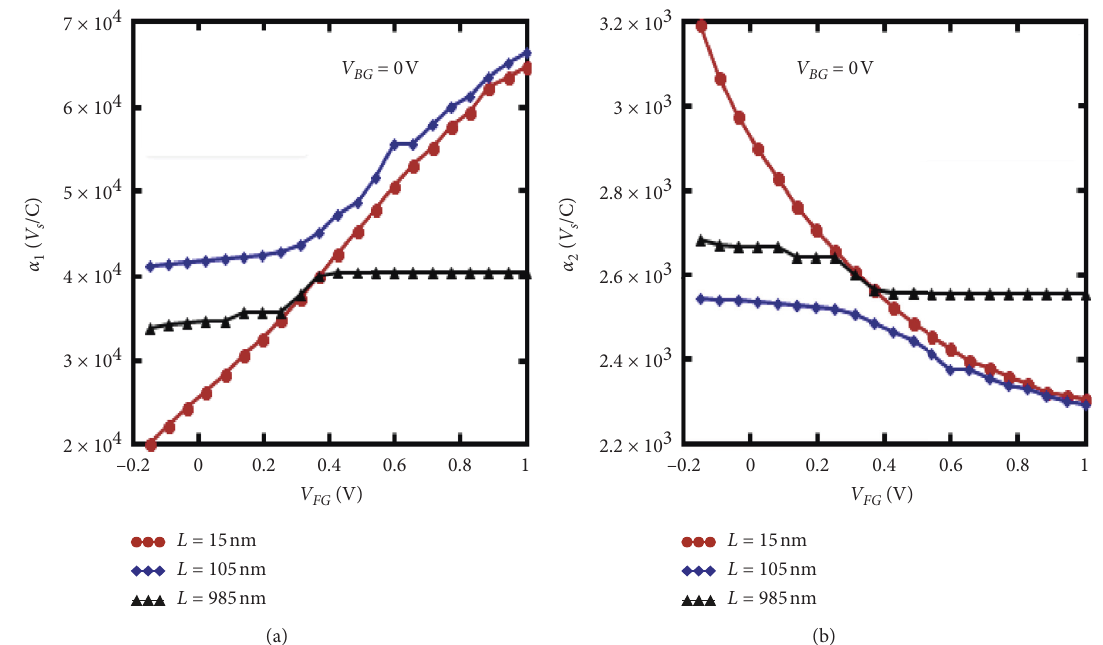
Figure 3: Numerical calculation results of RCS factors for (a) front gate interface, and (b) back gate interface, versus front gate voltage V for various effective gate lengths, and fixed W � 1 μ m, with V BG � 0V and V d � 20 mV.